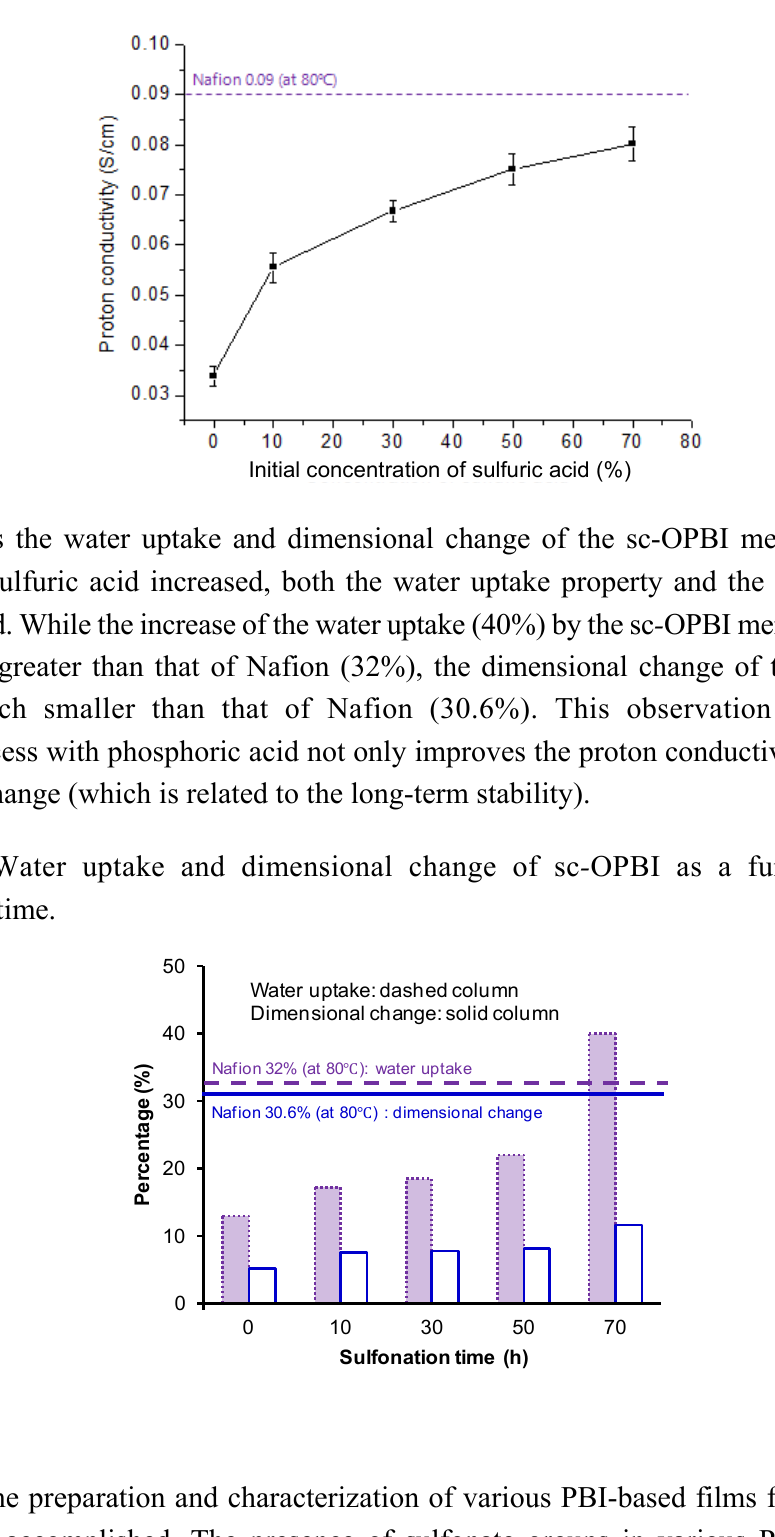
Figure 7. Proton conductivity of sulfonated cross-linked OPBI (sc - OPBI) as a function of the initial concentration of sulfuric acid used for sulfonation.